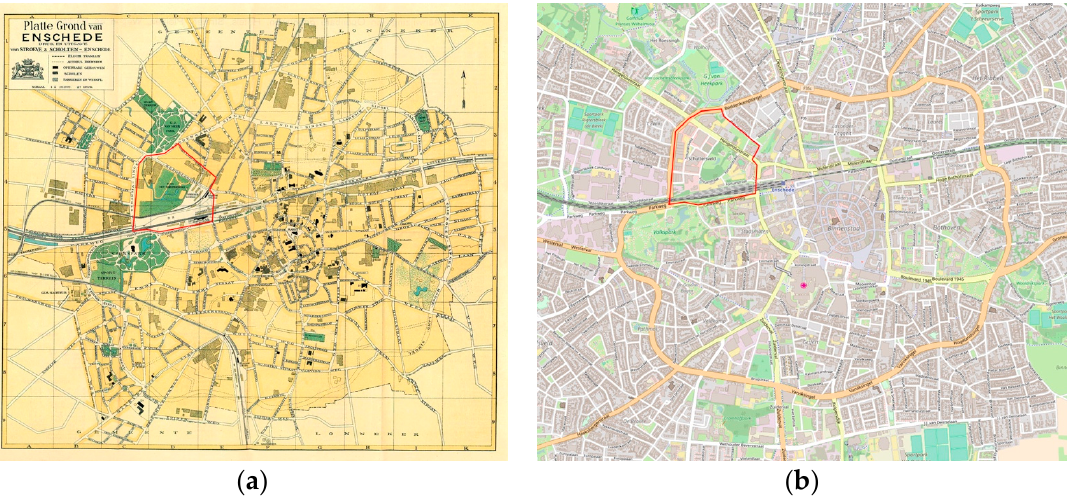
Figure 2. An old map ( a ) (adapted from [28]) and a digital map ( b ) of the fieldwork area within the city Enschede (the red line shows the boundary of the fieldwork area).